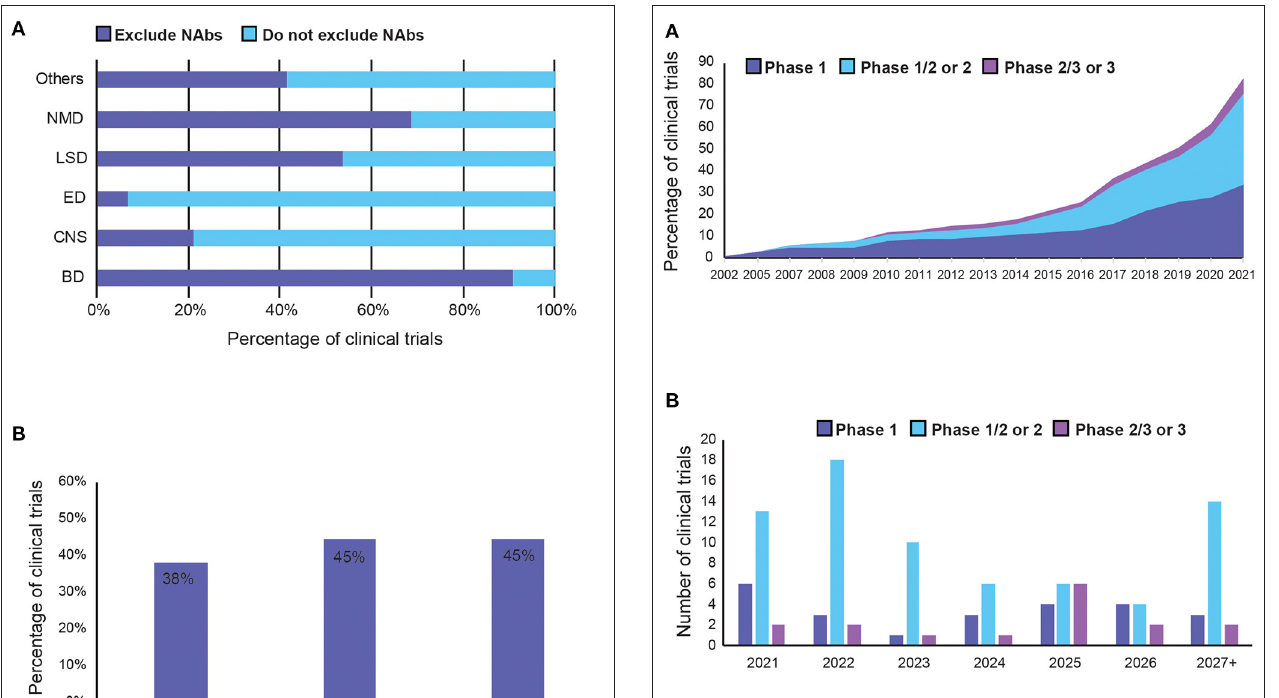
FIGURE 8 | Trends in adeno-associated vector (AAV)-mediated gene therapy in clinical trials. (A) Cumulative AAV-mediated gene therapy clinical trials completed in the past 20 years. (B) Expected number of of clinical trial completions in the next 5 years or more (see Supplementary Table 5 for